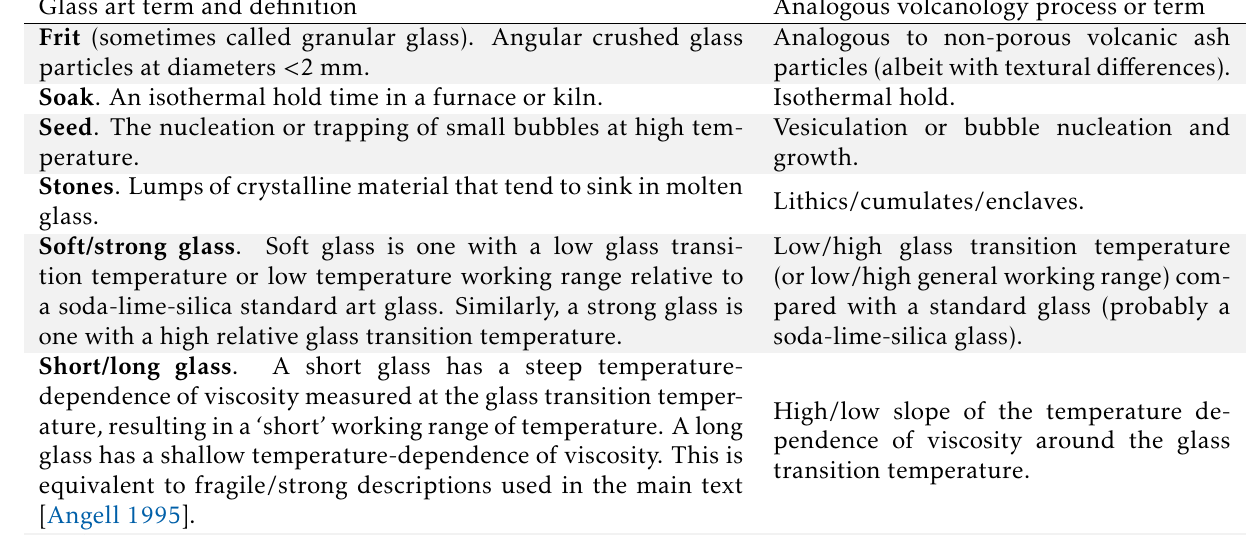
Table 1: A glossary of terms for dialogue between glass artists and